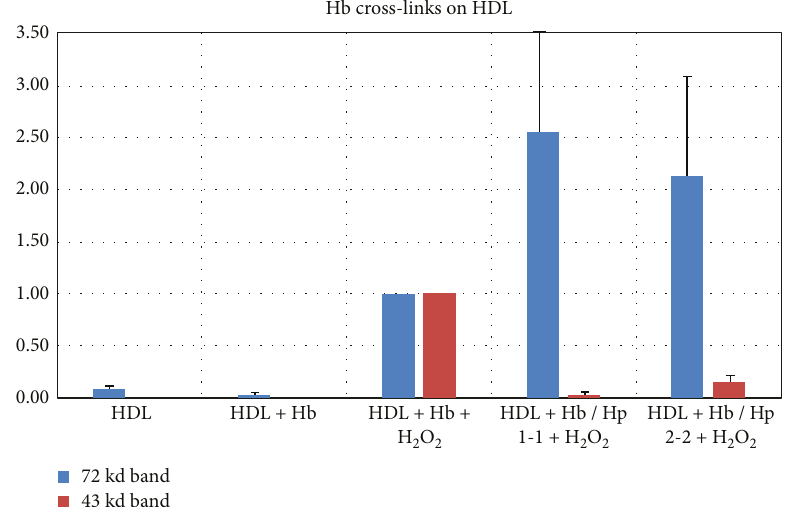
Figure 2: Measurement of Hb adducts with HDL. The 72 kd and 43 kd Hb immunoreactive bands were analyzed by ImageMaster, and the results were normalized to that obtained with HDL+Hb+ H preparations of each type (1-1 and 2-2) with each Hp preparation assessed twice. Data is reported as mean ± SD.